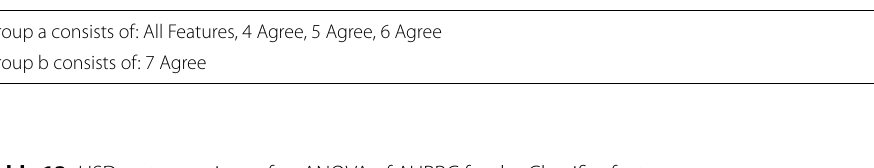
Table 13 HSD test groupings after ANOVA of AUPRC for the Classifier factor Group a consists of: CatBoost, RF, XGBoost, LightGBM